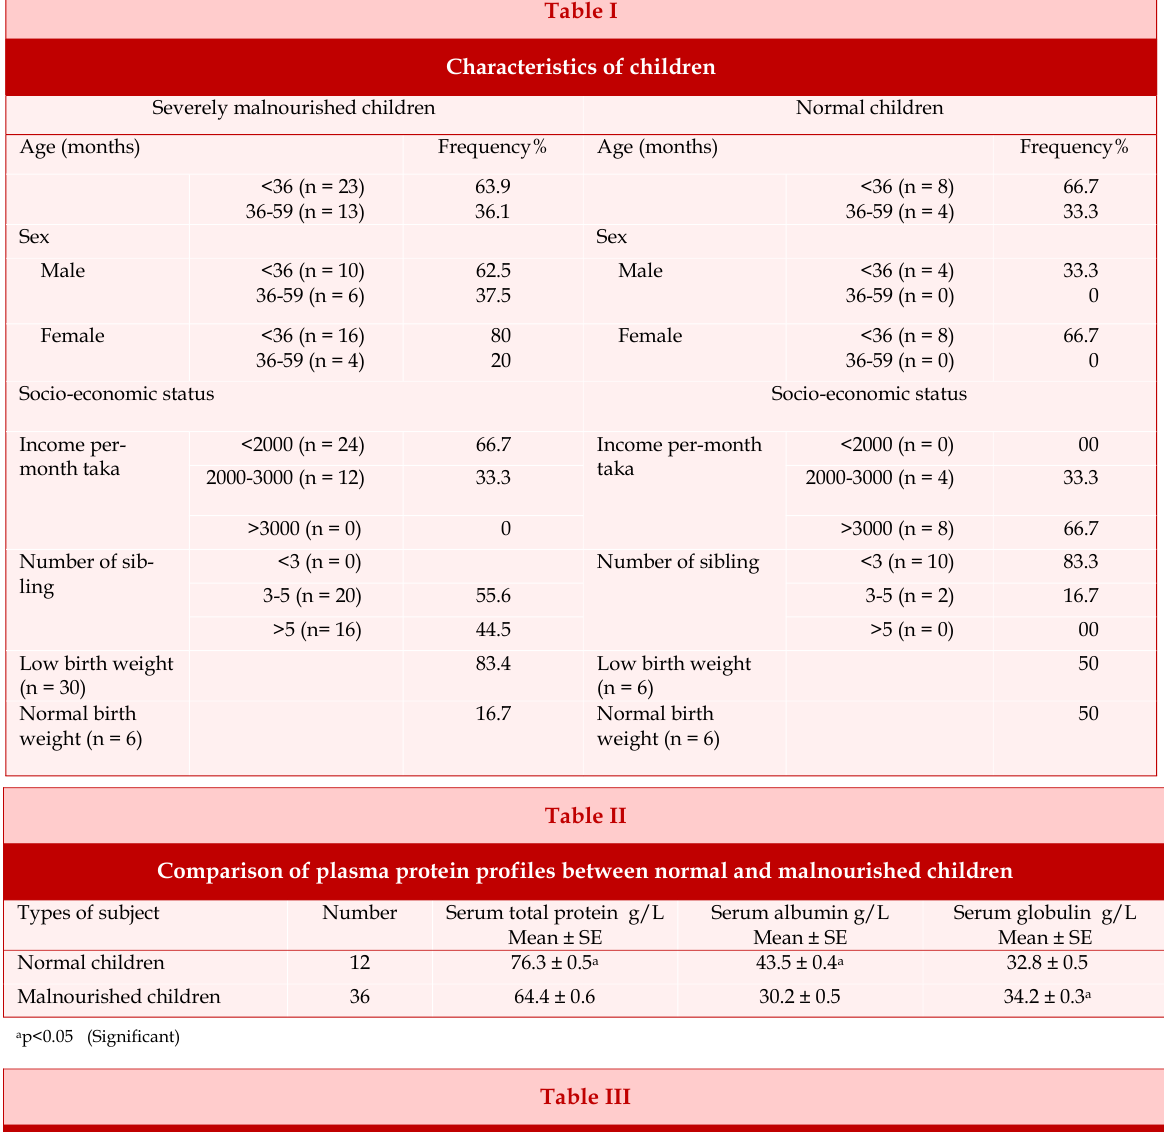
Comparison of serum iron, TIBC and transferrin saturation between normal and malnourished